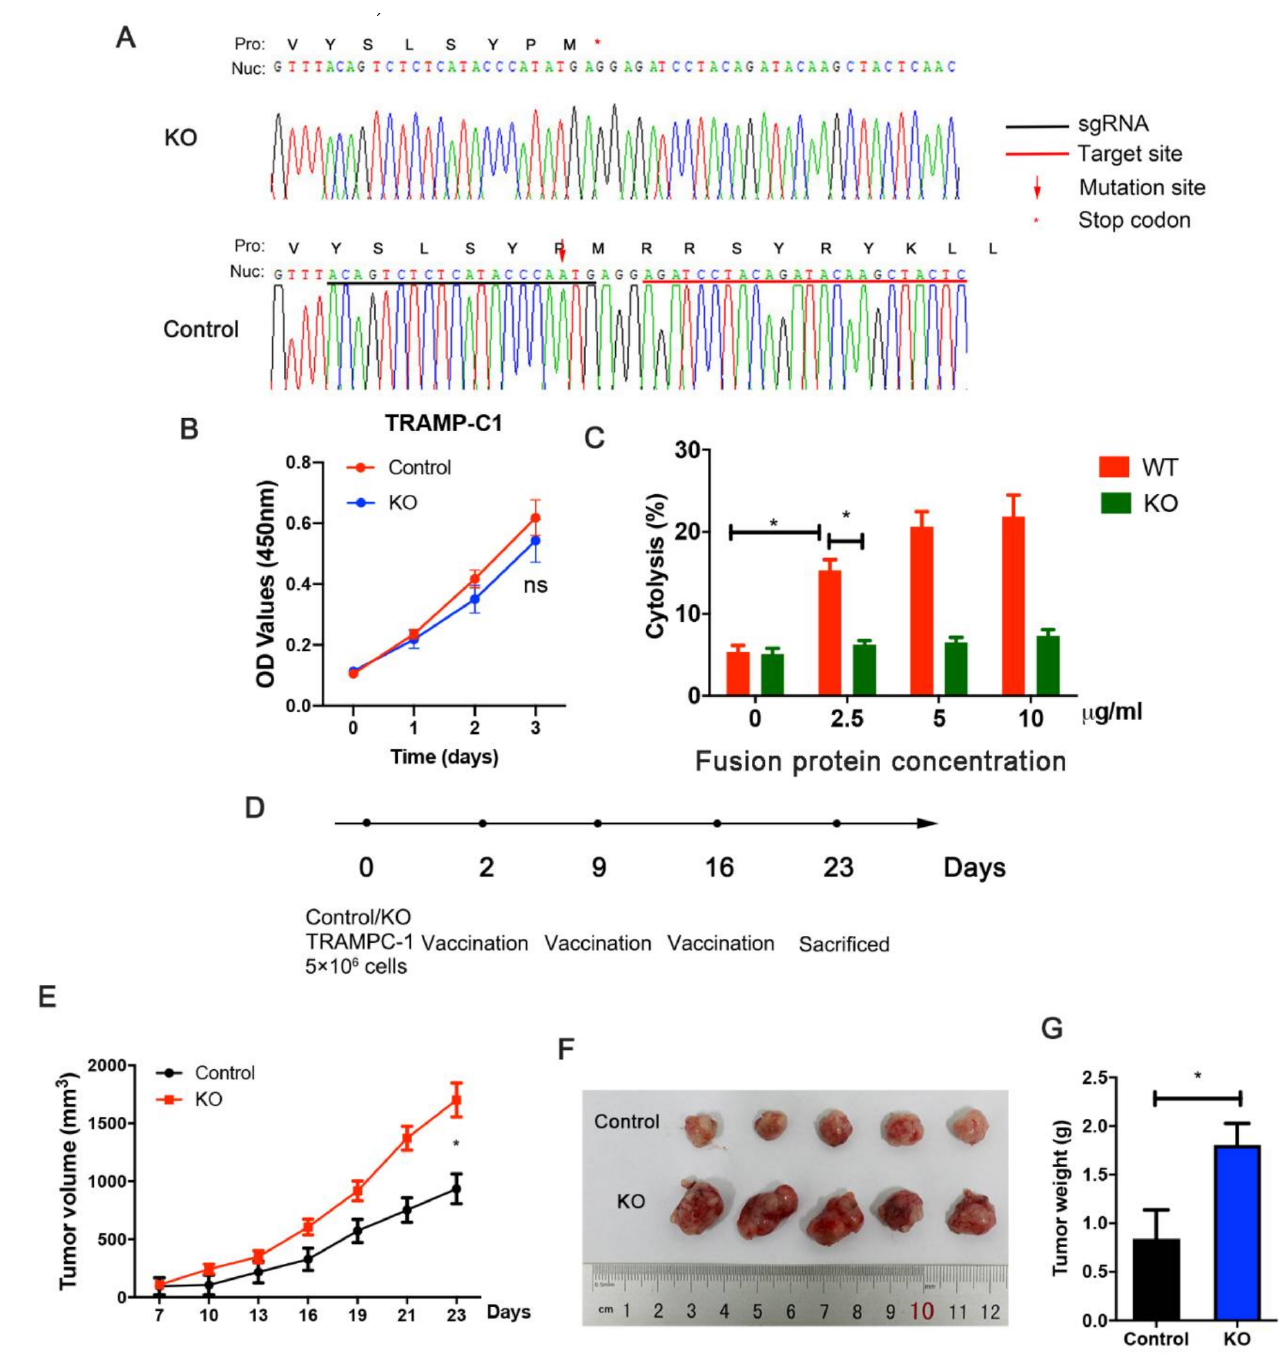
Figure 6. STEAP1 knockout suppresses immunization elicited by the fusion protein. ( A ) TRAMP-C1 cells with STEAP1 knockout (KO) verified using Sanger sequencing. ( B ) The CCK8 assay of wild-type (control) TRAMP-C1 cells and STEAP1- KO TRAMP-C1 cells. ( C ) The LDH assay performed to measure the cytotoxicity of effector T cells against KO cells and control TRAMP-C1 cells at different fusion protein concentrations. ( D ) Schematic diagram for xenograft. ( E – G ) Analysis of tumor weight and tumor growth of xenograft. * p <